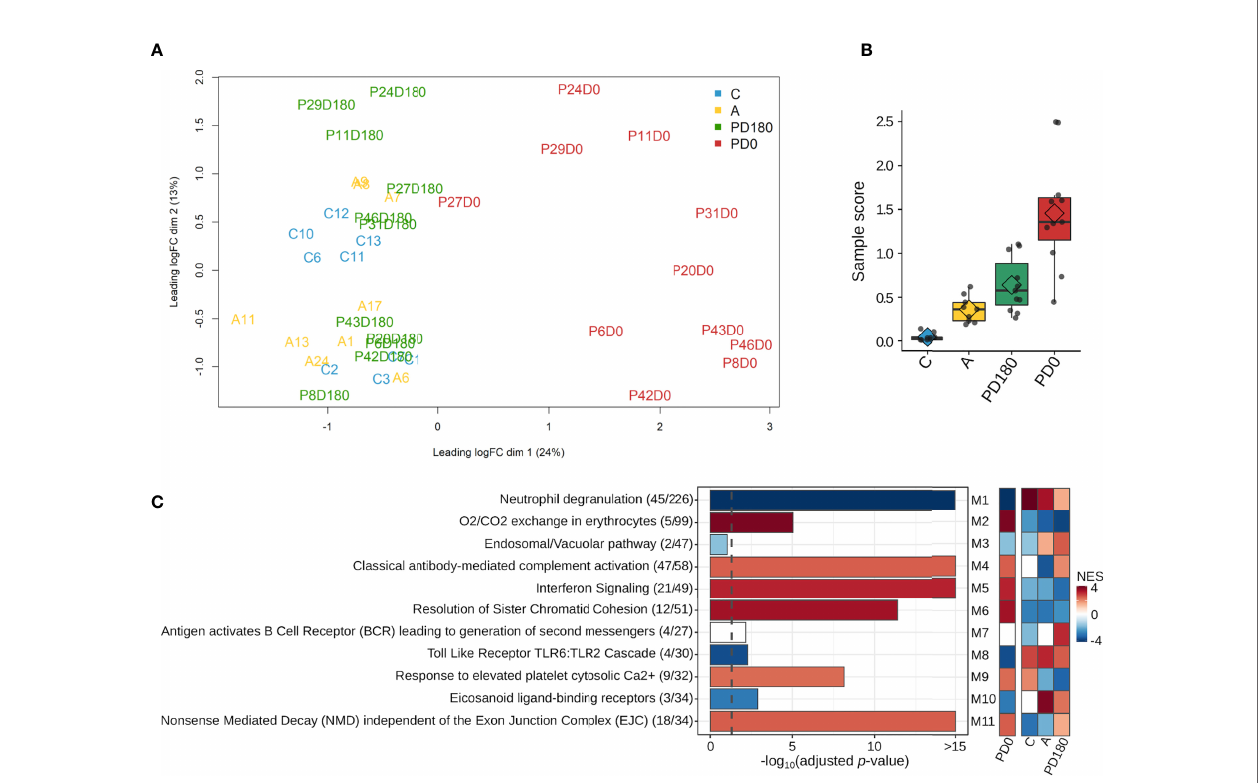
FIGURE 2 | Overview of the blood transcriptomes of this study. A total of 14,247 genes were expressed across the four groups, which encompassed 40 samples from 29 subjects. (A) Multidimensional scaling (MDS) plot and (B) molecular degree of perturbation (MDP) plot of all expressed genes in the four groups; (C) most signi fi cantly enriched pathways retrieved from the Reactome database for each module. The gene ratio for each pathway is displayed in parentheses. Colors in the Reactome enrichment graph refer to module activity in VL patients (PD0 group) as represented by the GSEA plot (heatmap in the right panel) displaying the module activity for each group. Color intensity is proportional to NES (normalized enrichment score). The graded scale side bar (NES) from red to blue indicates higher and lower activity, respectively, based on the ranked expression